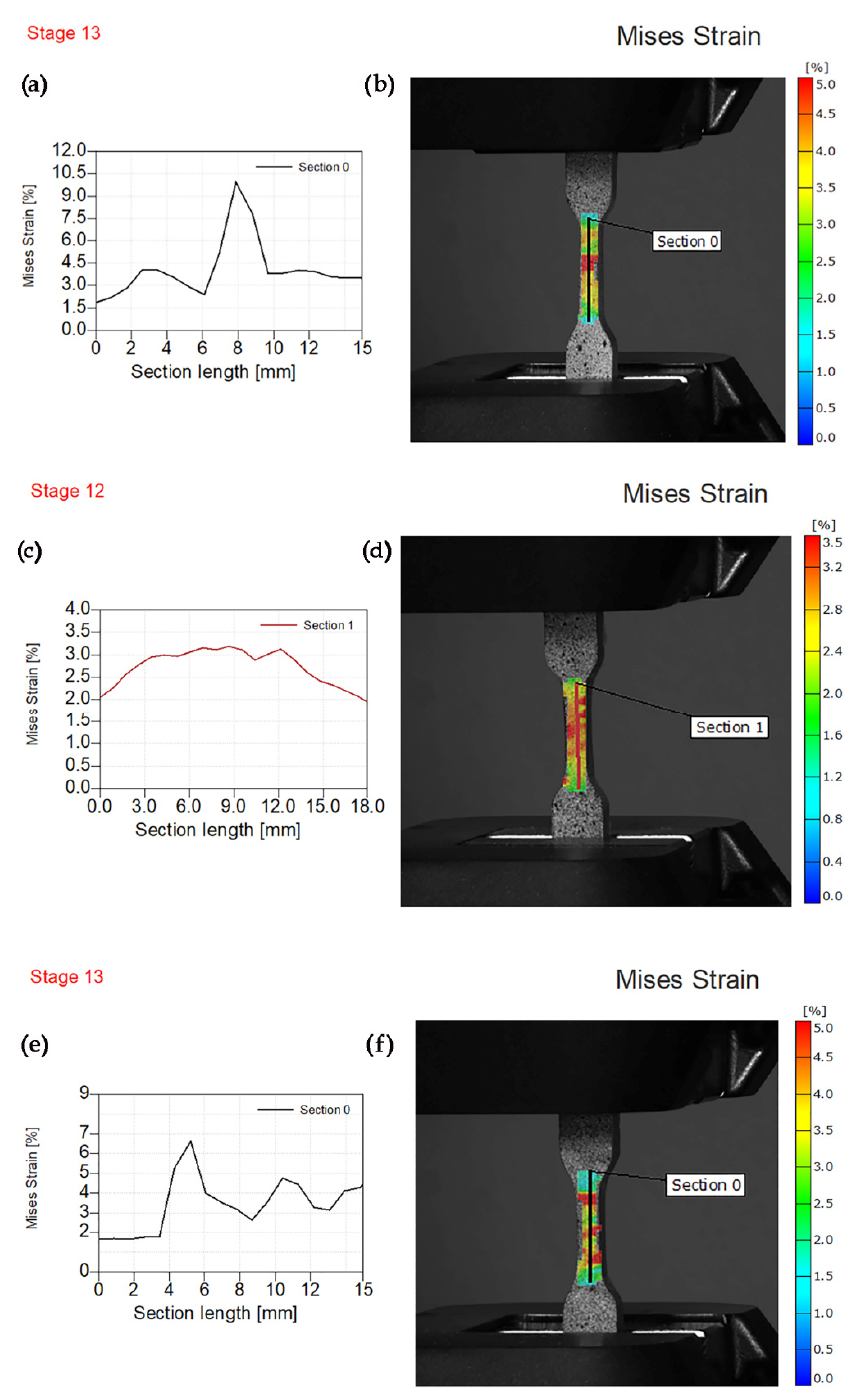
Figure 10. Experimental von Mises strain before fracture. ( a ) Von Mises strain—section length for PE/1MS. ( b ) Sample image PE/1MS with the overlaying von Mises strain field. ( c ) Von Mises strain—section length for PE/2MS. ( d ) Sample image PE/2MS with the overlaying von Mises strain field. ( e ) Von Mises strain—section length for PE/3MS. ( f ) Sample image PE/3MS with the overlaying von Mises strain field.